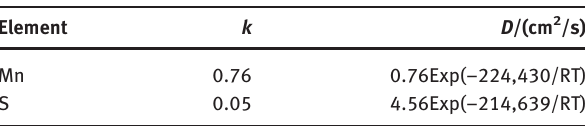
Table 4: The equilibrium partition coefficient ( k ) and diffusion coef- ficients ( D